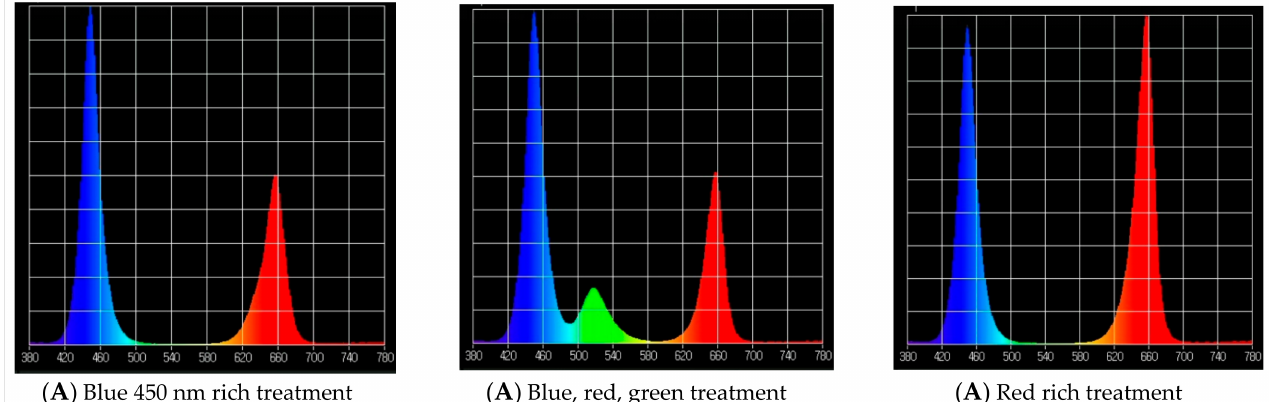
Figure 1. Spectra of the LED treatments (Blue 435 nm rich treatment, Blue 450 nm rich treatment and Red rich treatment), as measured by an UPRtek spectrophotometer: ( A ) the relative light intensity. ( B ) The radiant density of the light spectrum